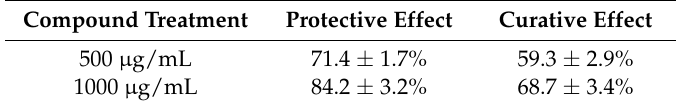
Table 2. Protection and curation effect of active compound against TMV.